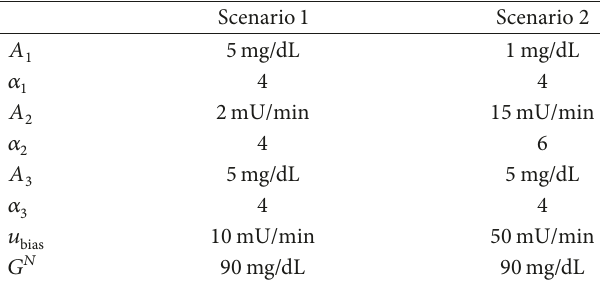
Table 2: The parameters of the applied cost function (10).